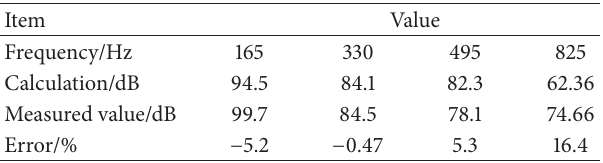
Table 5: Calculated and experimental values of accelerations level of 15 kW motor.